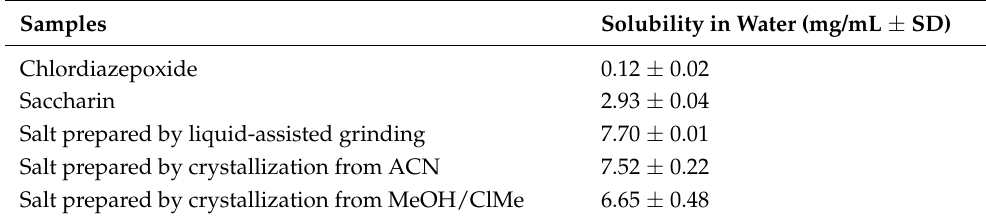
Table 8. Water solubility of chlordiazepoxide, saccharin, and saccharin salts of chlordiazepoxide prepared by different ways.